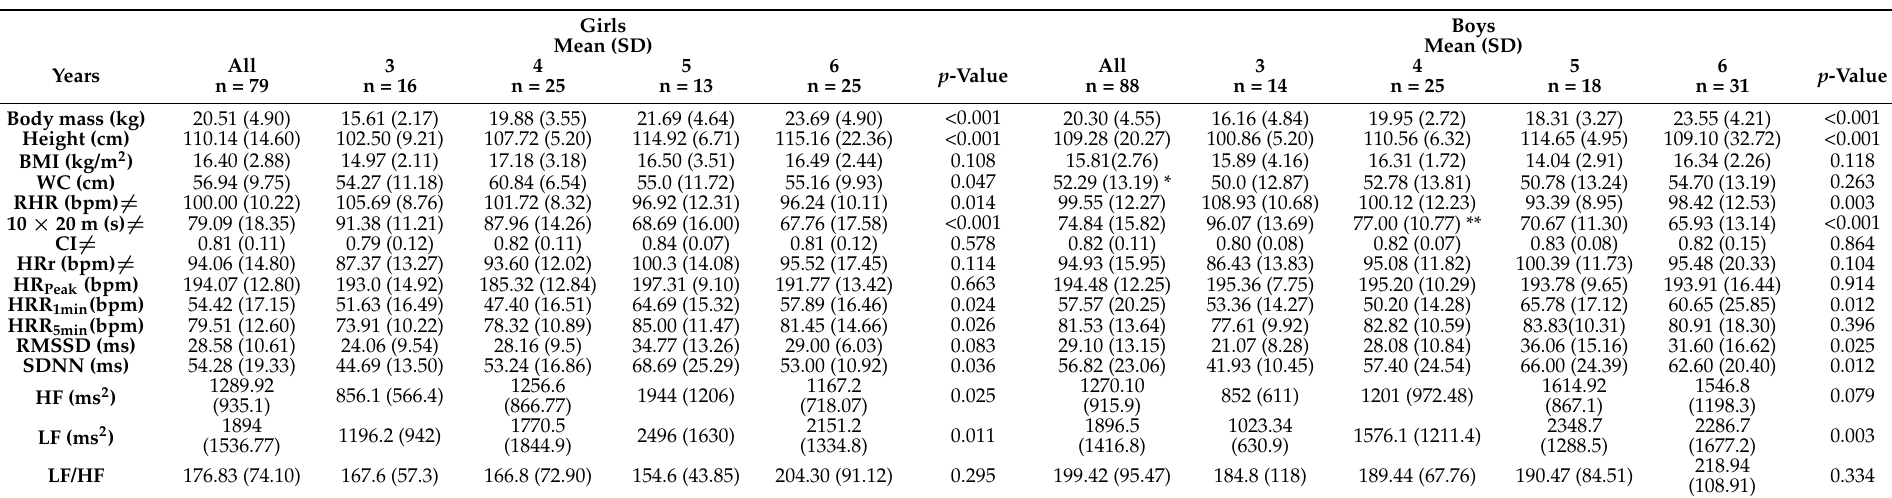
Table 1. Anthropometric characteristics, 10 × 20 m test, and heart rate response concerning sex and age